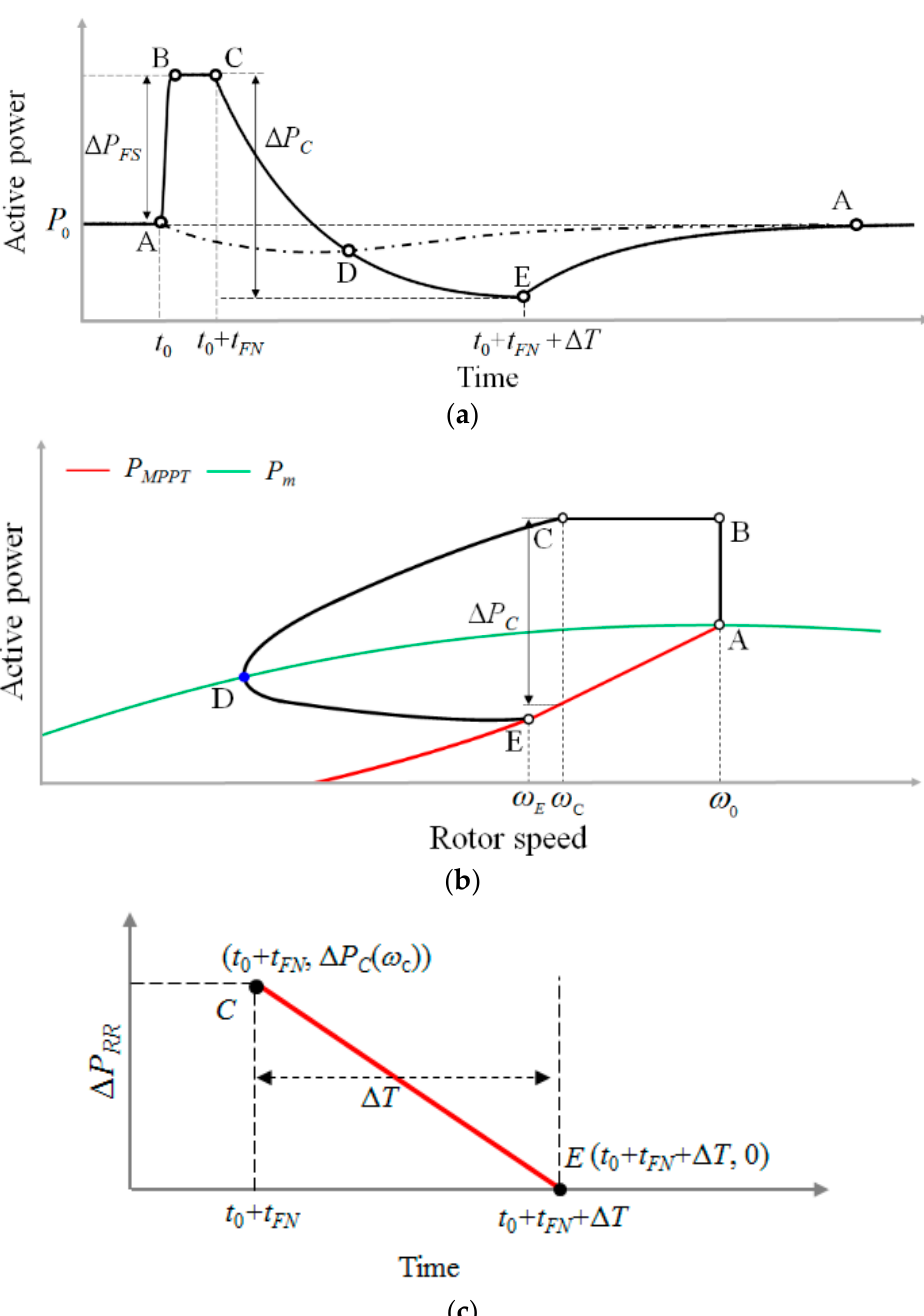
Figure 6. Power reference of the proposed scheme. ( a ) Power reference in the time domain; ( b ) Power reference in the rotor speed domain; ( c ) Regulation characteristics of Δ P RR .